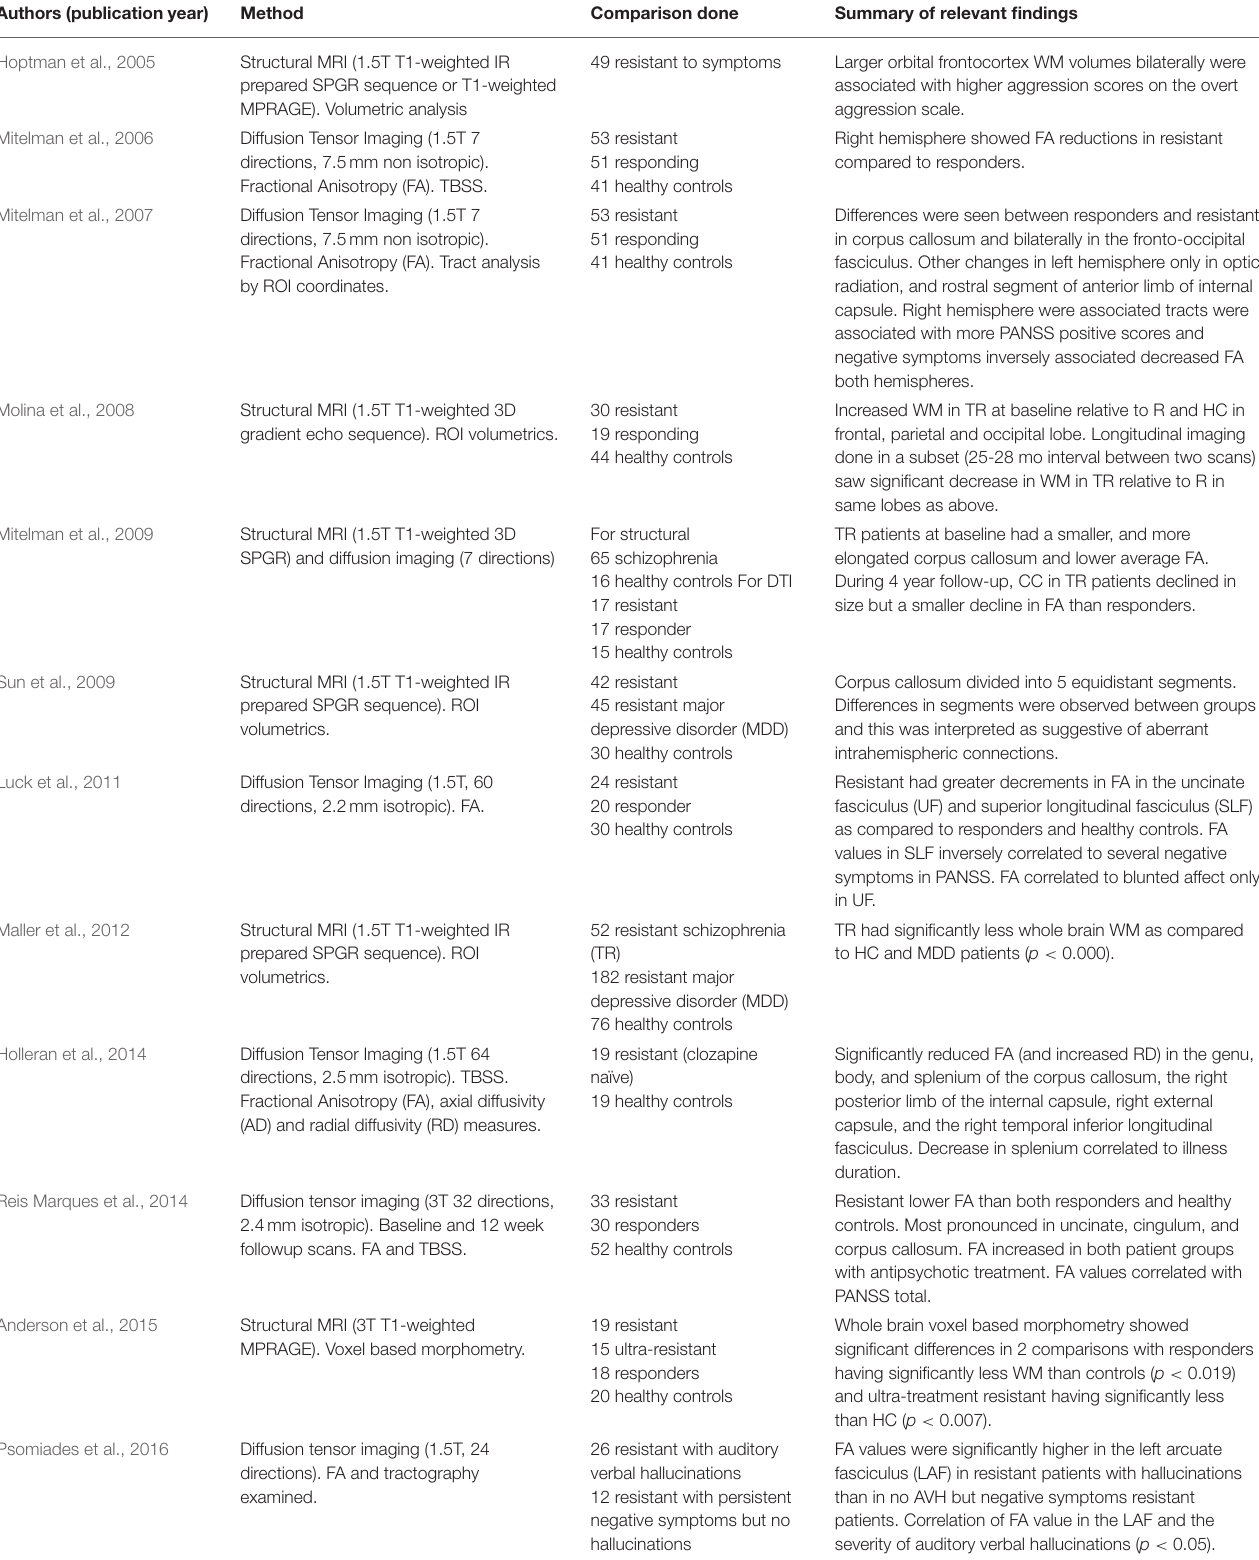
TABLE 1 | List of White matter and Pharmacoresistance Clinical Studies